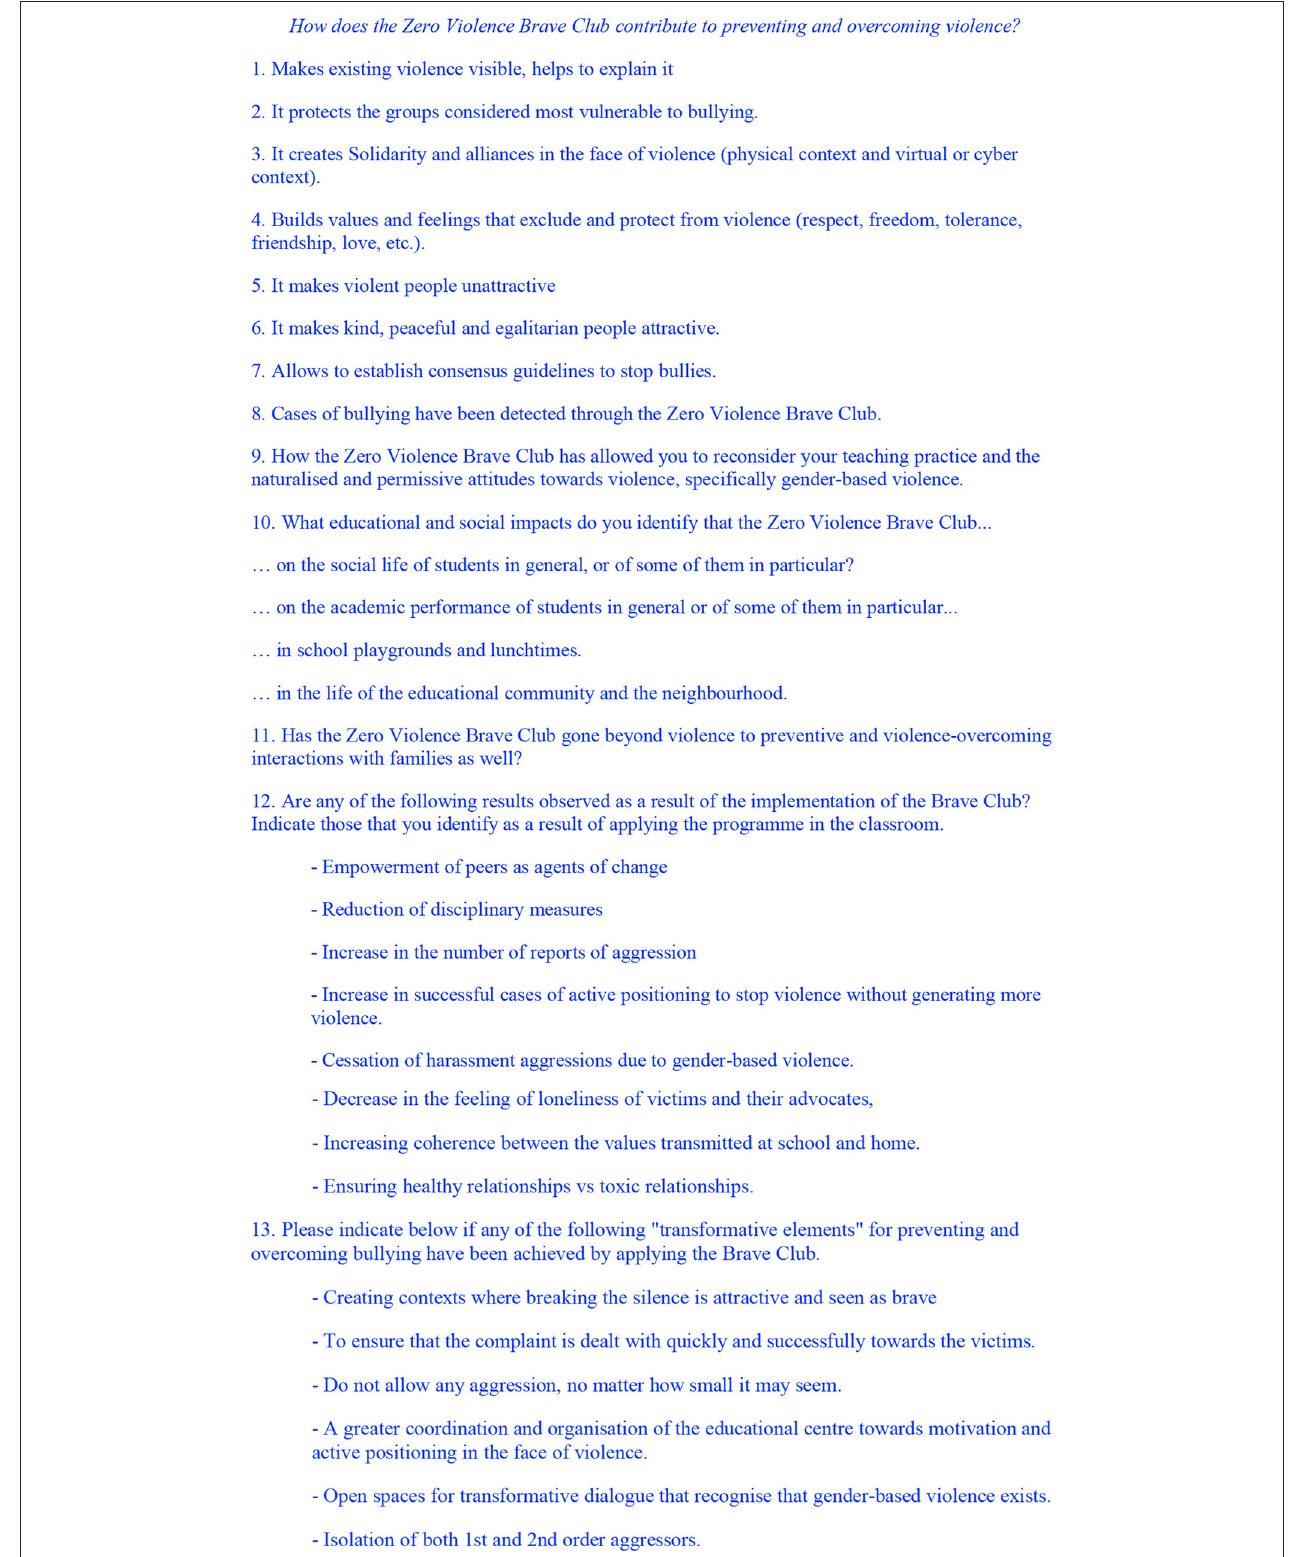
FIGURE 1 | Online interview outline with teachers who apply Zero Violence Brave Club at school with children.